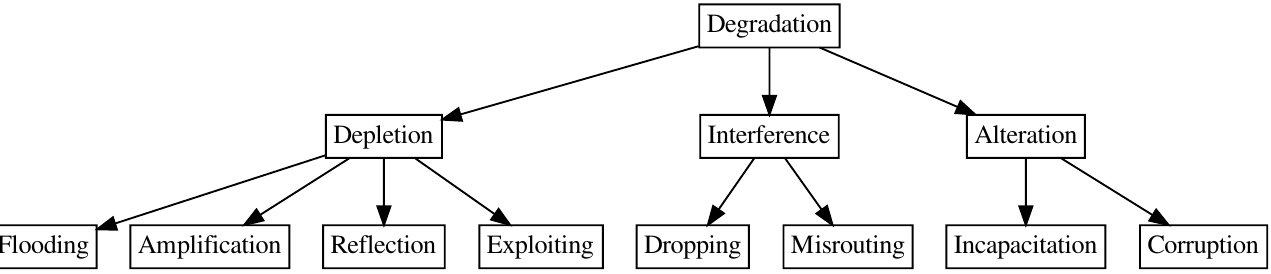
Figure 1. Degradation techniques